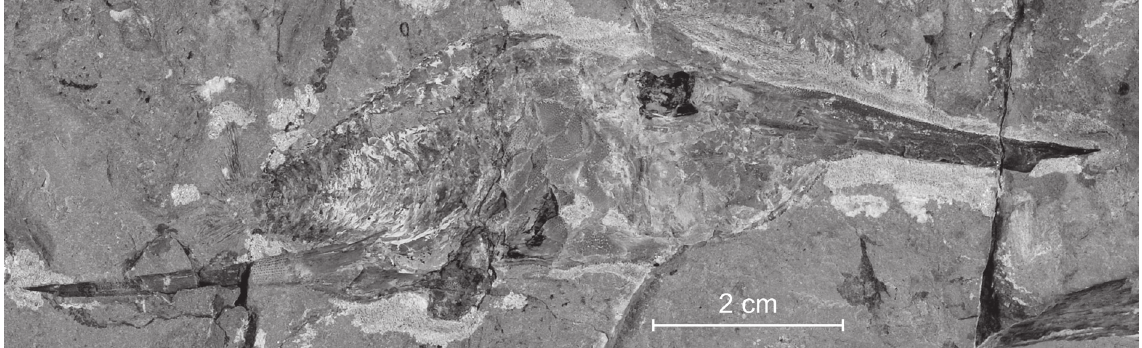
Fig. 1. Gladiopycnodus karami gen. et sp. nov. Holotype CLC S-393.